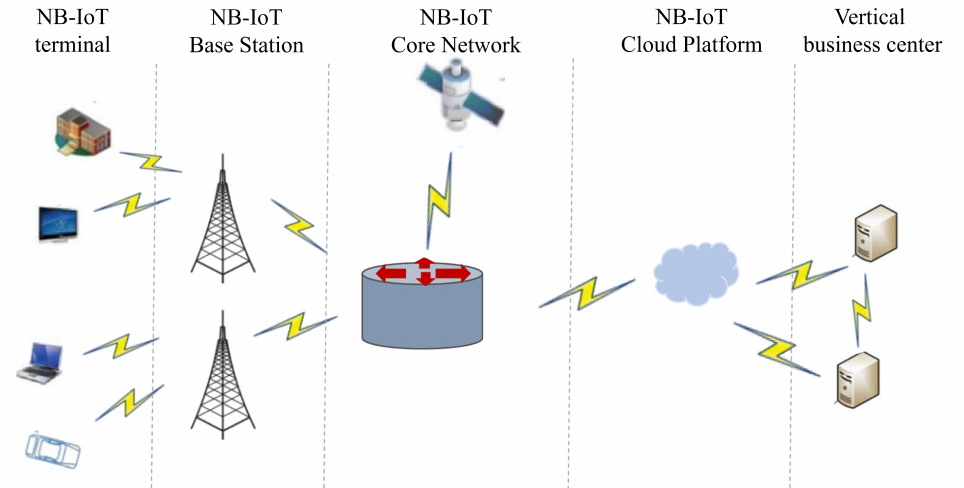
Figure 14. NB-IoT network